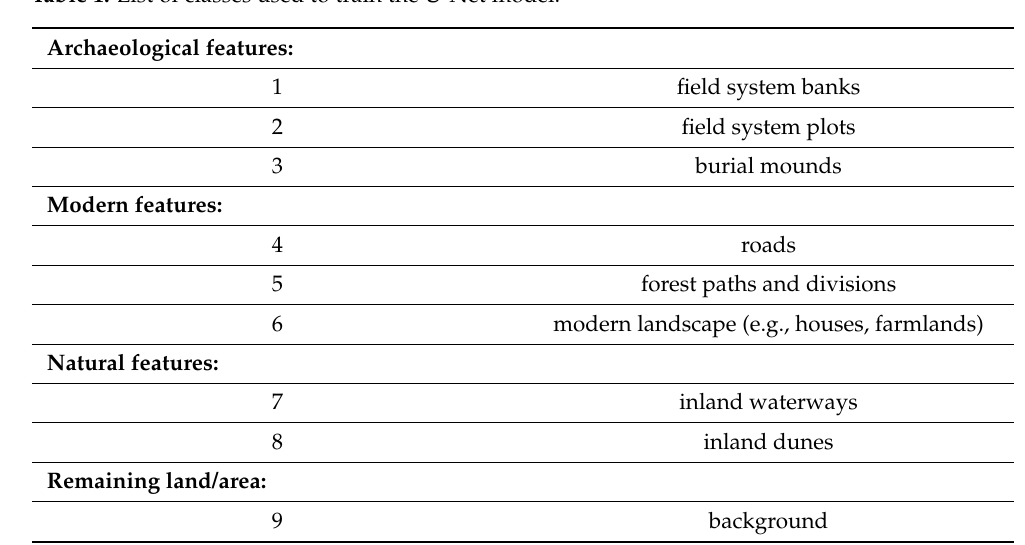
Figure 5. Examples (30 × 30 m) from the burial mounds category. The visualization used is the Simple Local Relief Model. Table 1. List of classes used to train the U-Net